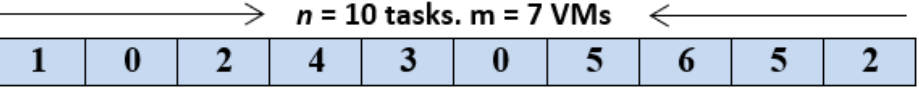
Figure 2. A solution representation for task scheduling in cloud computing. This figure starts by numbering the cells with 0 and ends with an index of 9 for the last cell, such that the cell 0 indicates the first task, and the second cell indicates the second task, and so on.